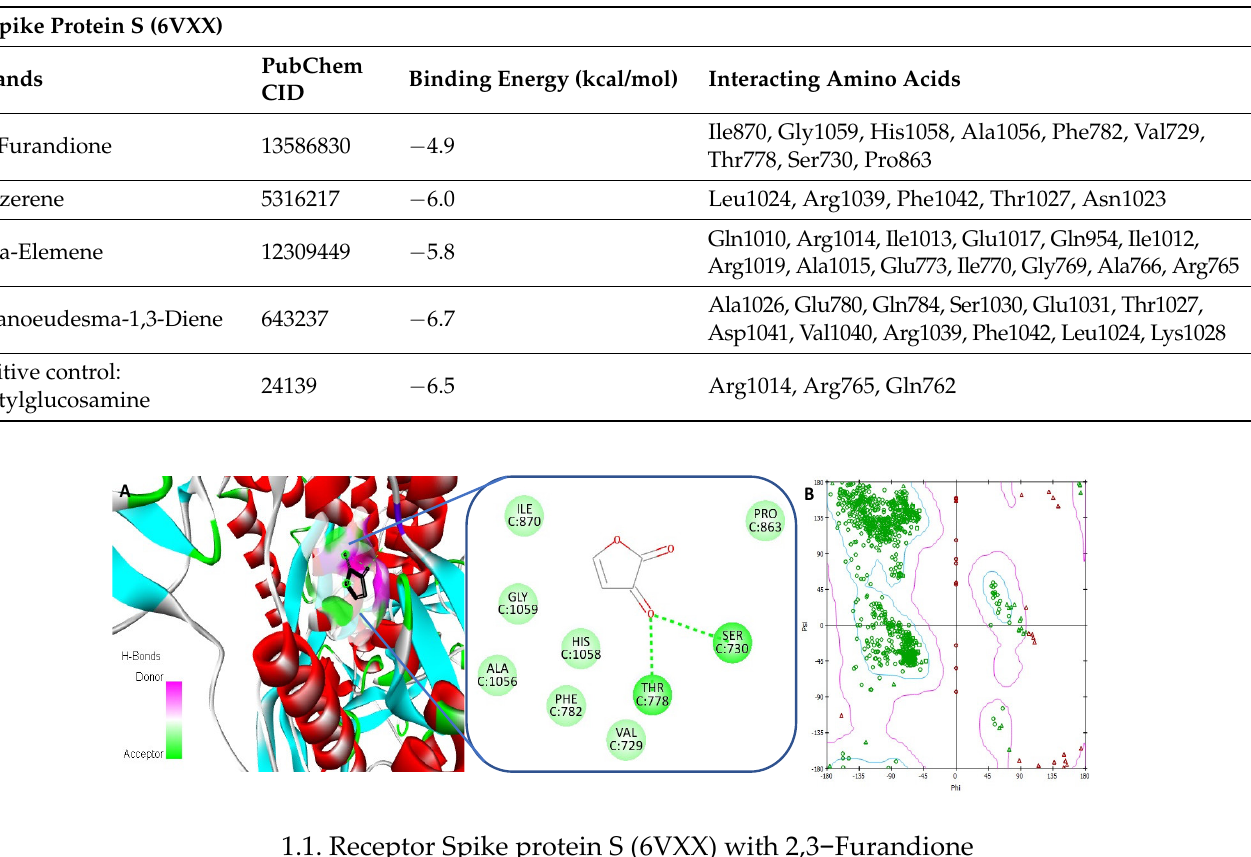
Table 3. Specifications of docking investigations; the ligands, interacting functional residues (amino acids) of receptor Spike protein S (6VXX), and corresponding binding energy.